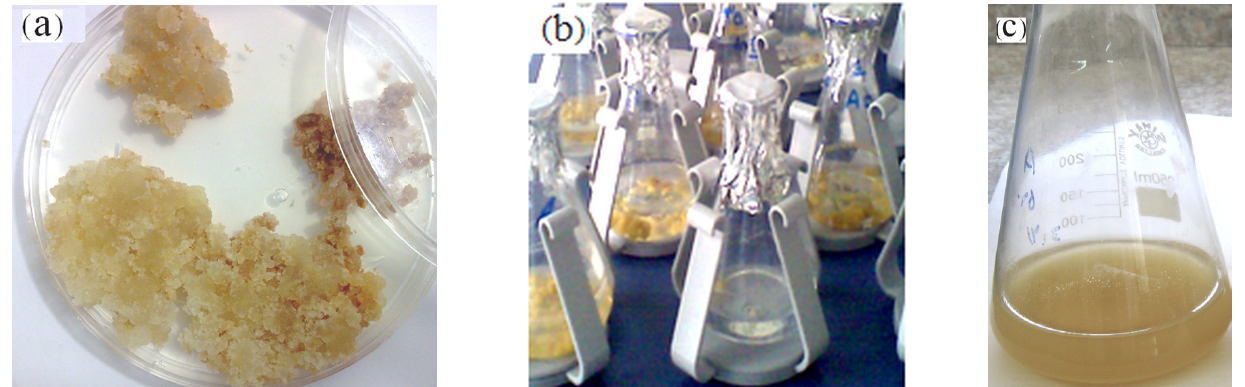
Fig. 2. Callus culture of Bunium persicum in MS solid medium, 3 month after inoculation (a) and Cell suspension cultures . Aggregative cells, 8 weeks after culture (b) and separated cells after sieve